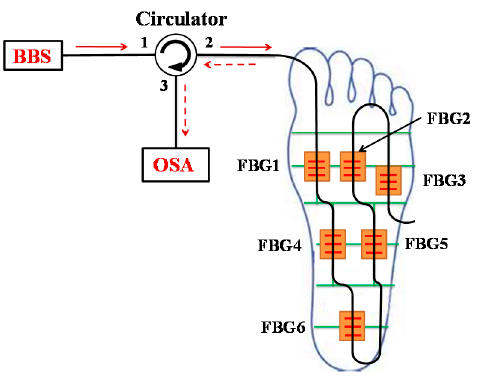
Figure 2. The configuration of the fiber sensing system for plantar pressure measurement.